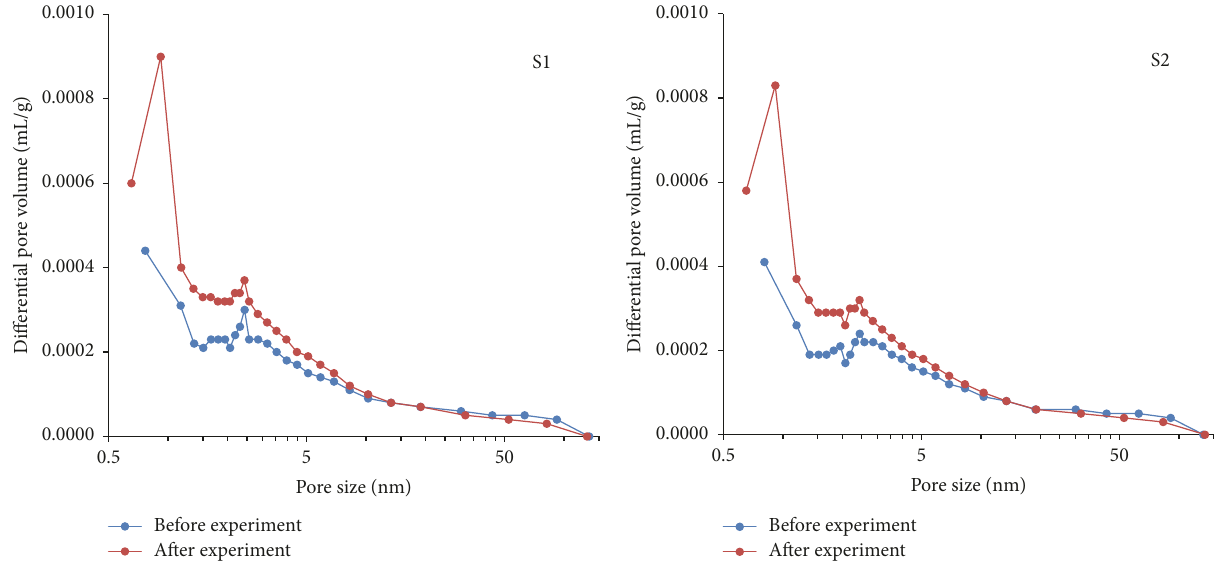
Figure 13: Pore size distributions before and after the experiments.